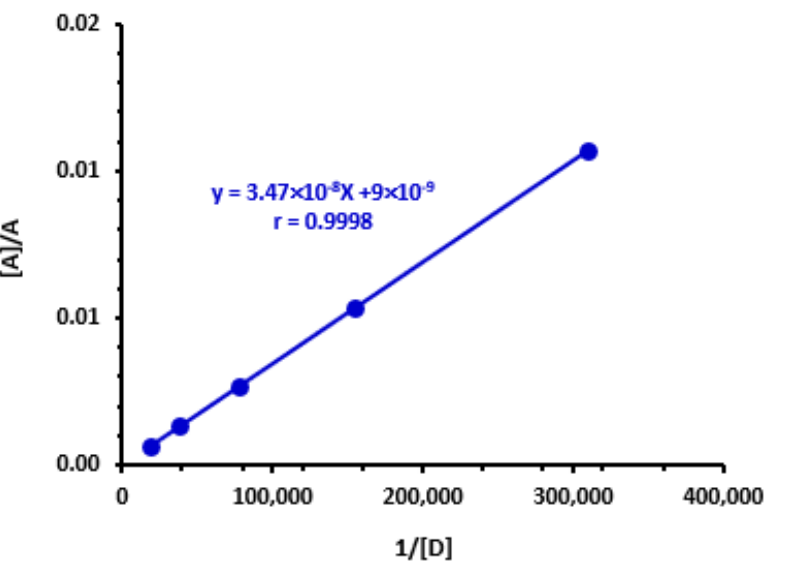
Figure 4. Benesi-Hildebrand plot of the CT complex of iodine with AXT and the linear fitting equation with correlation coefficient (r). [A], A and [D] are the molar concentration of iodine, the absorbance of the reaction mixture of the complex, and the molar concentration of AXT, respectively.